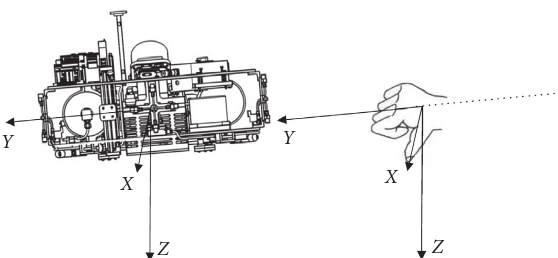
Figure 4: Judging the direction of eccentricity by the right-hand